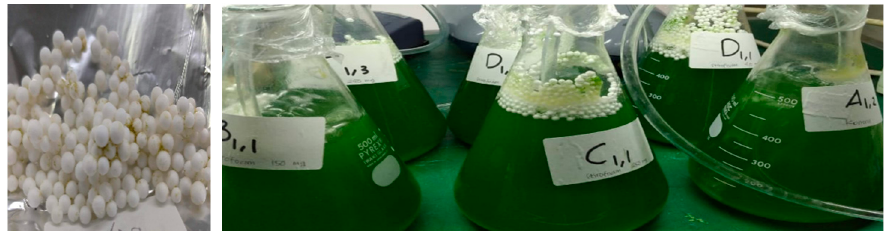
Figure 1. Microplastic Styrofoam with a diameter of 2 mm ( left ) and implementation of Styrofoam in microalgae culture ( right ).